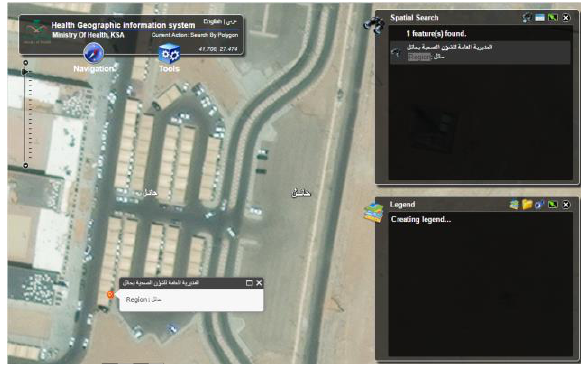
Fig. 2 : Health Geographic Information System web portal (MOH,